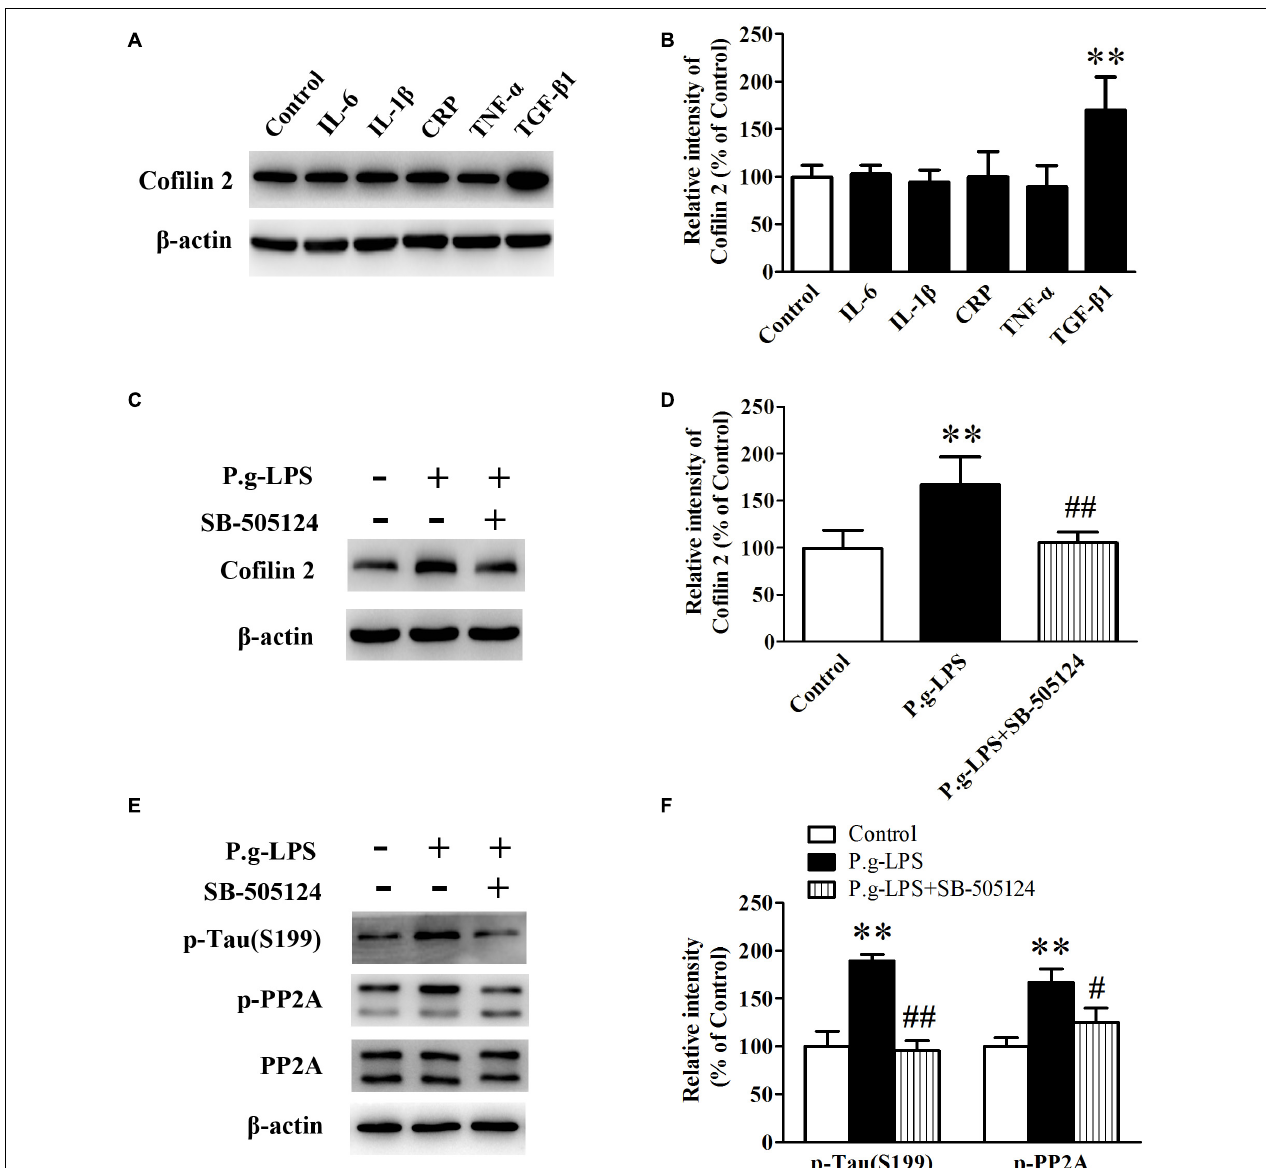
FIGURE 6 | TGF- β 1 was involved in Cofilin 2 upregulation in P.g-LPS treated SK-N-SH APPwt cells. (A,B) Representative panel and quantitative comparison of the Western blot of Cofilin 2 in IL-6-treated group, IL-1 β -treated group, recombinant Human CRP-treated group, TNF-a-treated group, TGF- β 1-treated group and Control group. (C,D) Representative panel and quantitative comparison of the Western blot of Cofilin 2 in Control group, P.g-LPS-treated group, and P.g-LPS plus SB-505124-treated group. (E,F) Representative panel and quantitative comparison of the Western blot of p-Tau (Ser199) and p-PP2A in Control group, P.g-LPS-treated group, and P.g-LPS plus SB-505124-treated group Data represent mean ± SD. ∗∗ p < 0.01 compared with control group, # p < 0.05 compared to P.g-LPS group, ## p < 0.01 compared to P.g-LPS